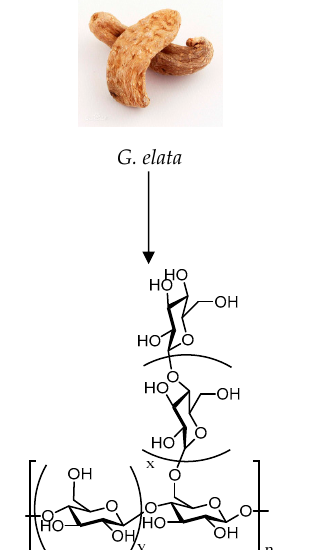
Figure 1. Chemical structure of part of the polysaccharides derived from G. elata : x + y = R; 1. AGEW: R = 14; 2. WTMA: R = 15; 3. WGEW: R = 16; and 4. PGEB-3 H : R = 20 [5]. R = 14; 2. WTMA: R = 15; 3. WGEW: R = 16; and 4. PGEB-3 H : R = 20